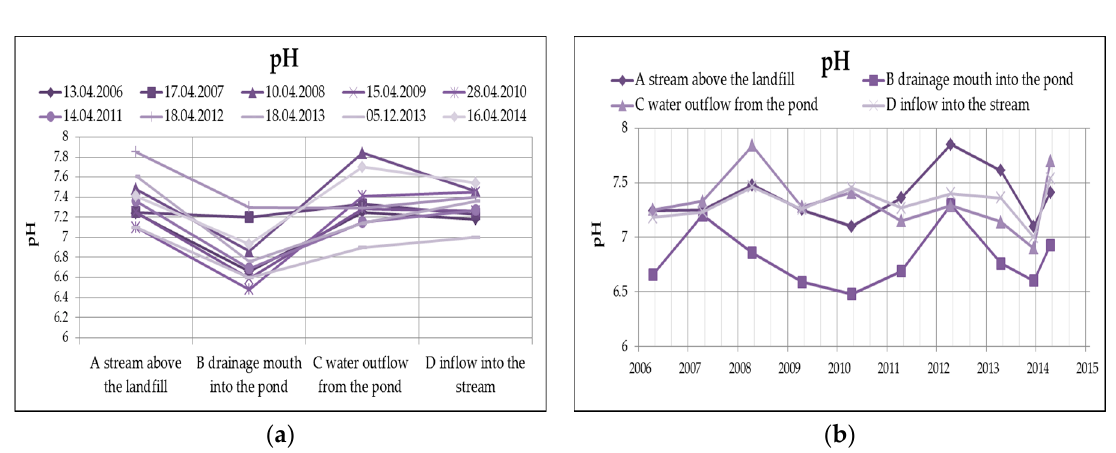
Figure 6. Change of values of pH in surface water depending on the monitored profile ( a ) and time ( b ).